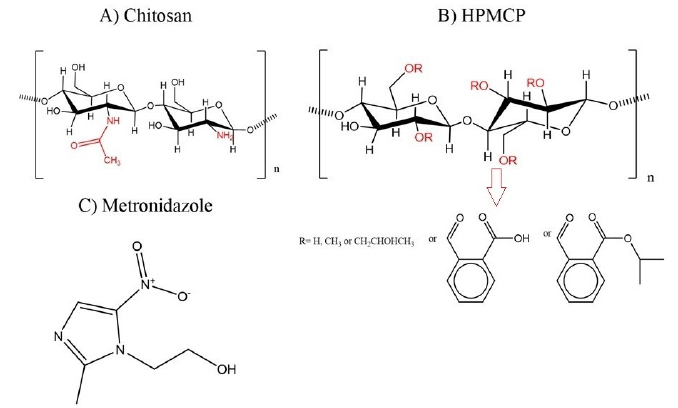
Figure 1. Molecular structures. ( A ) Representation of monomeric units forming chitosan, N-acetyl-D-glucosamine, and predominance of D-glucosamine, with acetamide and amine groups in red. ( B ) Representation of monomeric units of 2-hydroxypropylmethyl ether, phthalic acid ester (HPMCP), with substitute groups in red, indicated by the arrow. ( C ) Metronidazole.